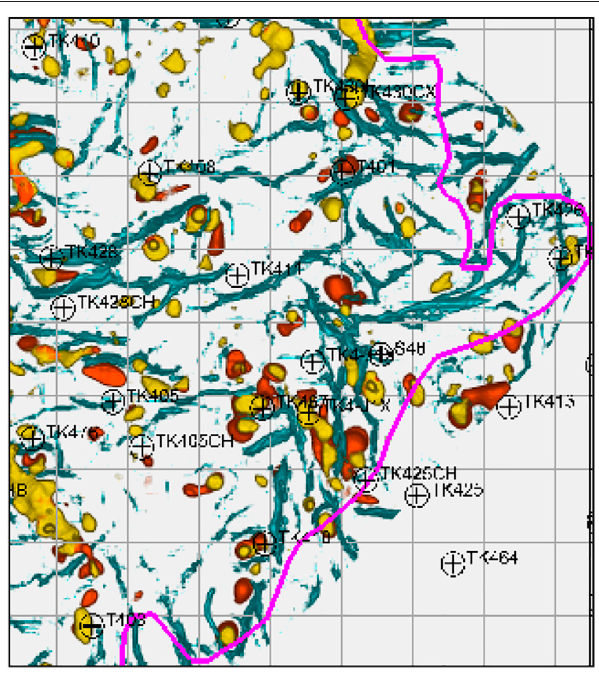
FIGURE 19 | Seismic multi-attribute plane superposition of 0 – 80 ms below plane